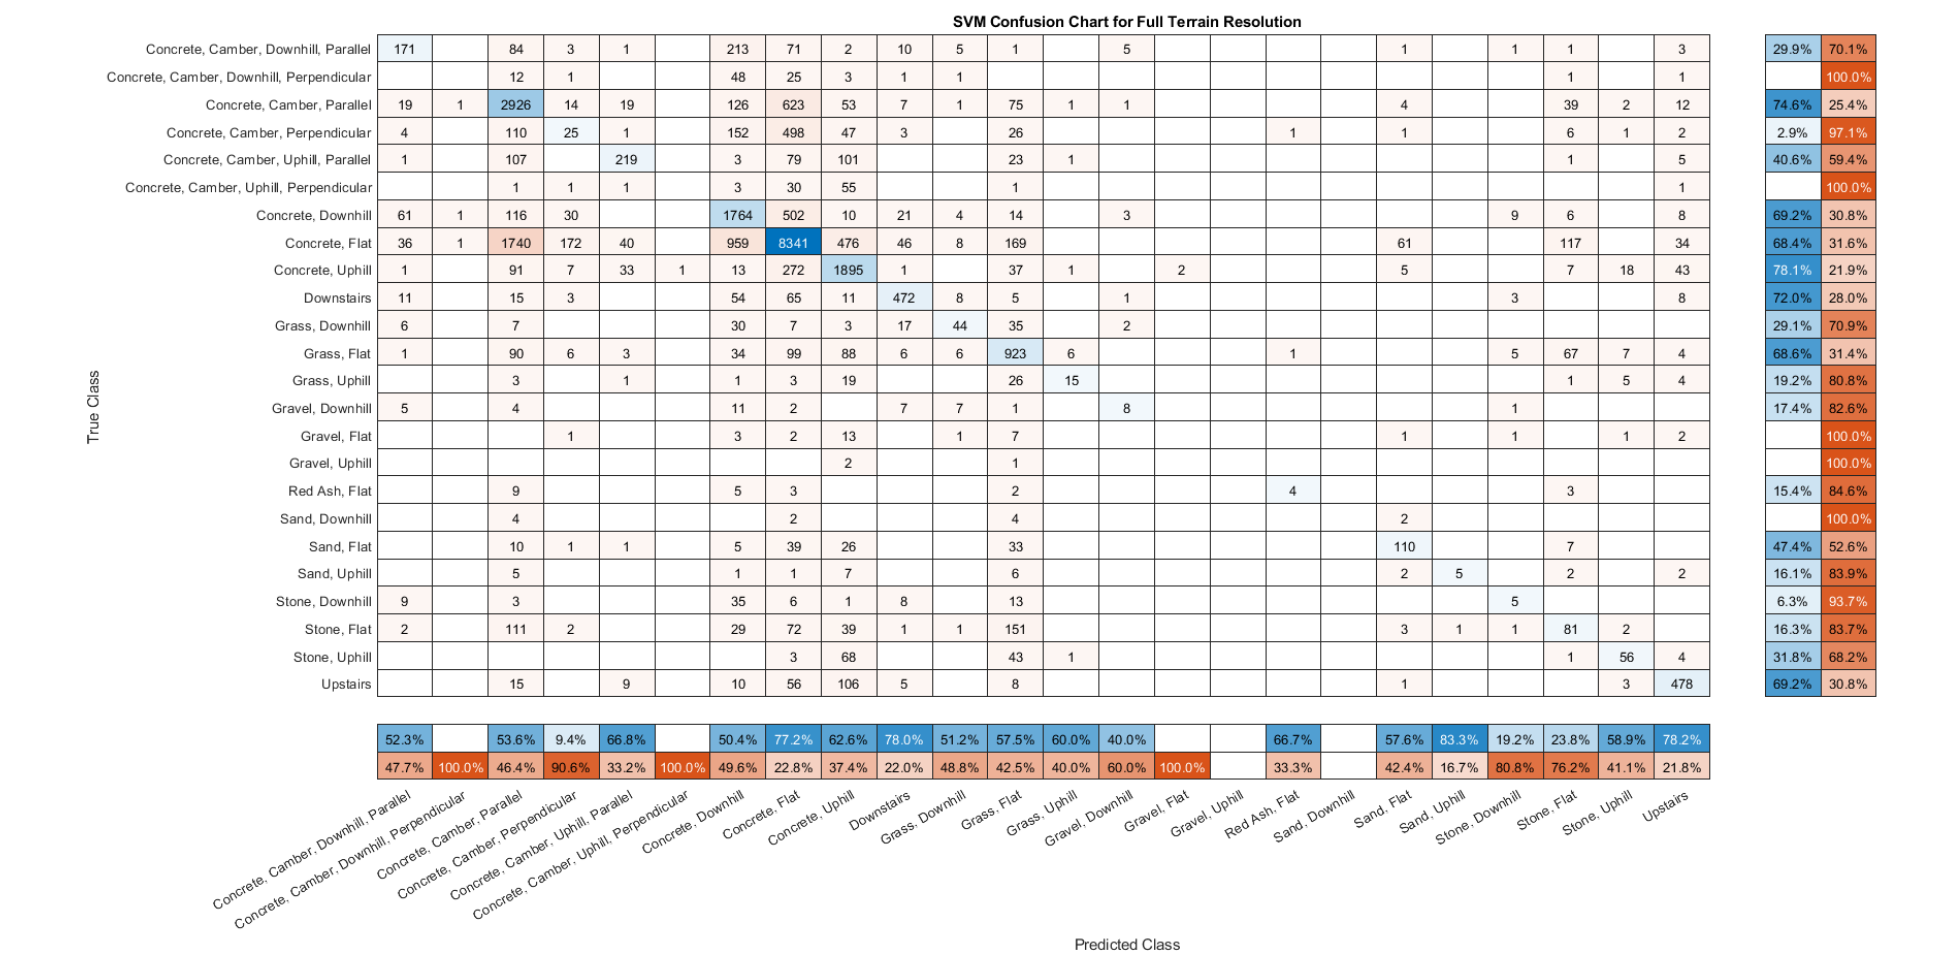
Figure A3. Support Vector Machine Confusion Chart for Level 3 label